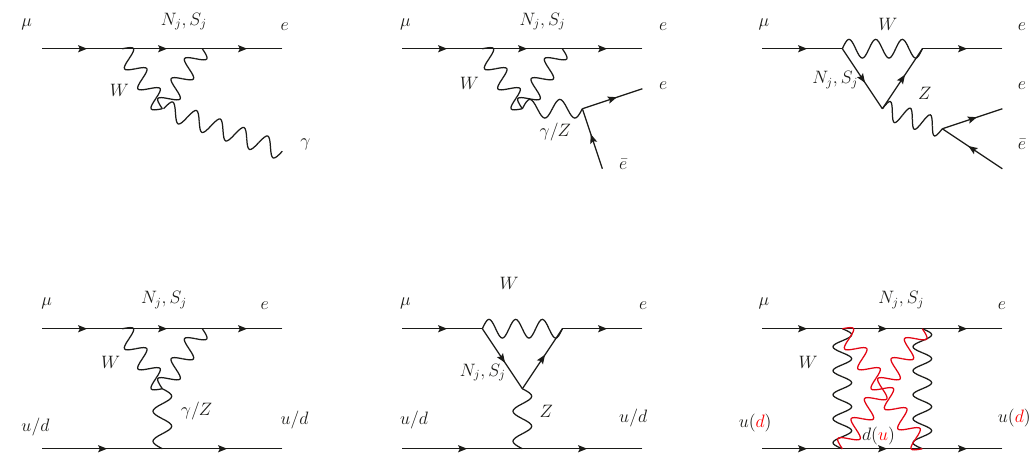
Figure 18 . Feynman diagrams for LFV